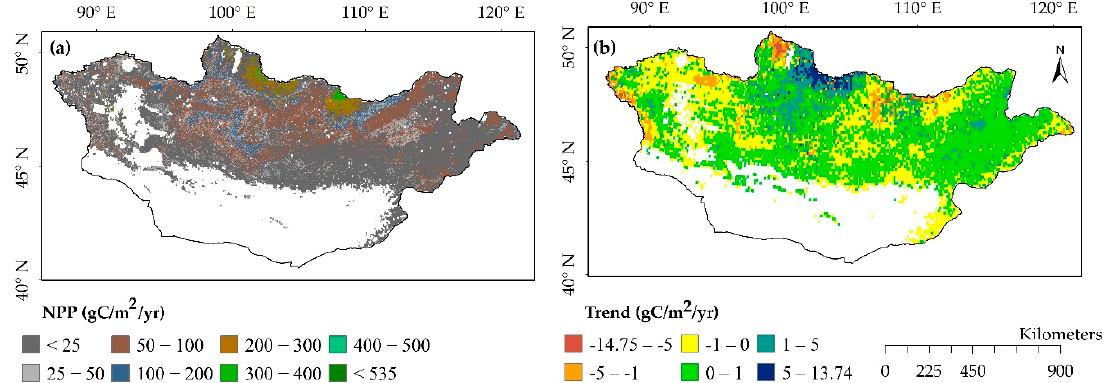
Figure 4. ( a ) Spatial pattern of mean annual NPP from the year 2003 to 2018. ( b ) The spatial pattern of the trend in annual NPP during the study period. Note: The white-colored areas in figure NPP represent a non-vegetation.